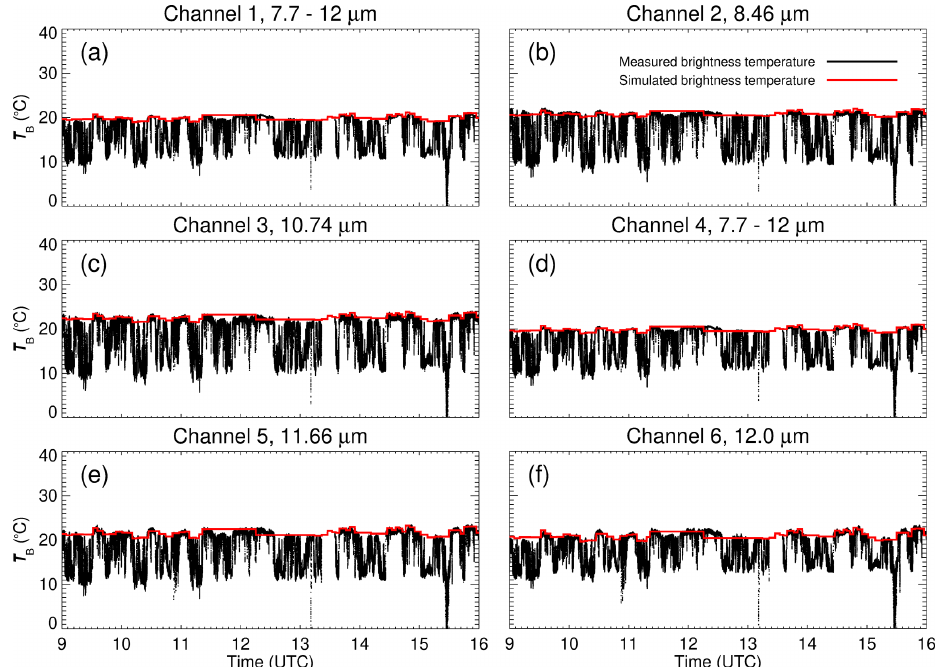
Figure 6. Time series of brightness temperature observed by the central 10 × 10 pixels of the thermal imager during the EUREC 4 A flight on 13 February 2020. Each panel, (a) to (f) , displays the brightness temperature observed by the use of the different channels (black) and the corresponding cloud-free simulations (red).